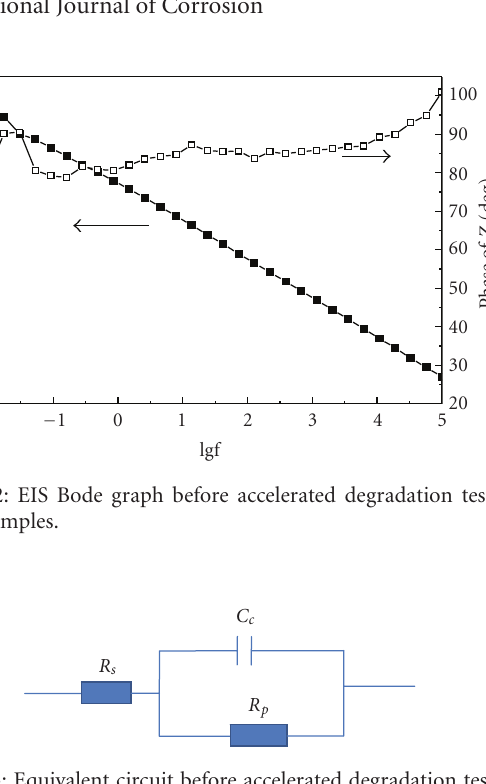
Figure 3: Equivalent circuit before accelerated degradation test of coated samples.